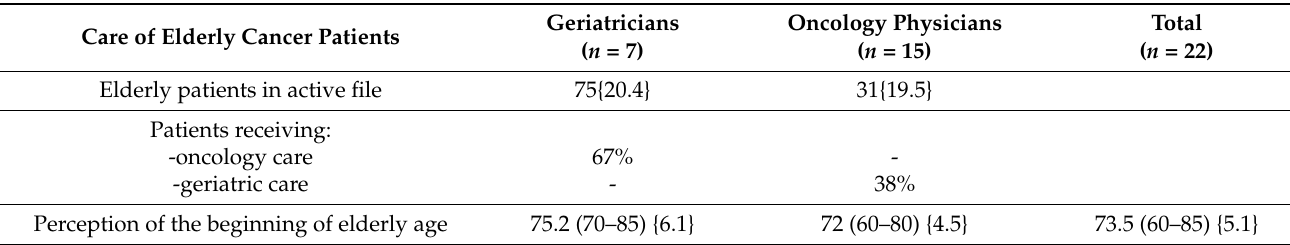
Table 2. Physicians’ care and perception of elderly cancer